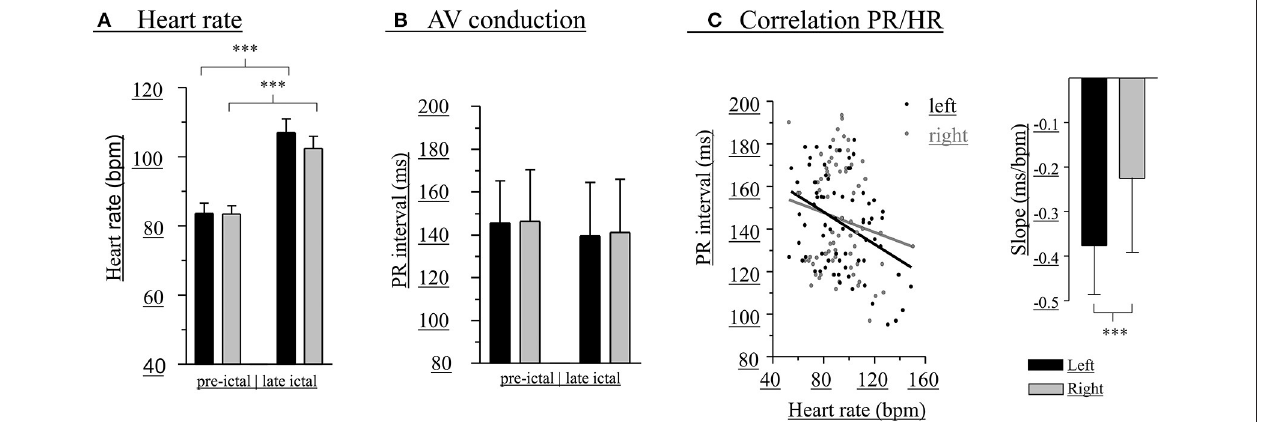
FIGURE 2 | Modulation of PR intervals is greater with left-hippocampal seizures. Heart rate before (left bars) and during (right bars) unilateral hippocampal seizures (A) . PR interval before (left bars) and during (right bars) unilateral hippocampal seizures (B) . PR interval/HR correlations and slopes (inset) (C) . A total of 56 seizures (black bars, left-sided seizures; gray bars, right-sided seizures) of 14 patients was included. *** p <